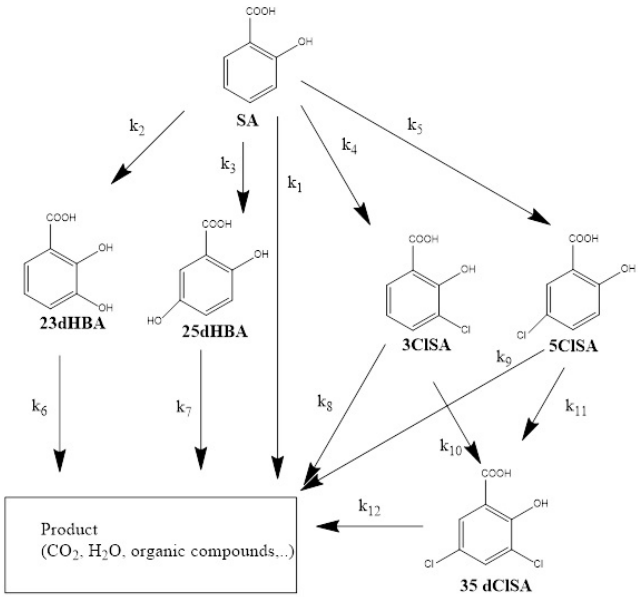
Figure 3. Simplified chemical kinetic model for the degradation of SA.